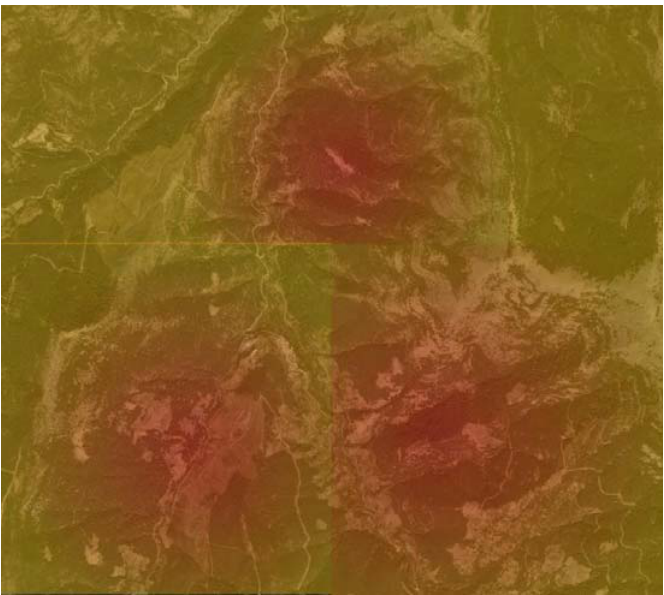
Figure 3. Simulated thermal map of a